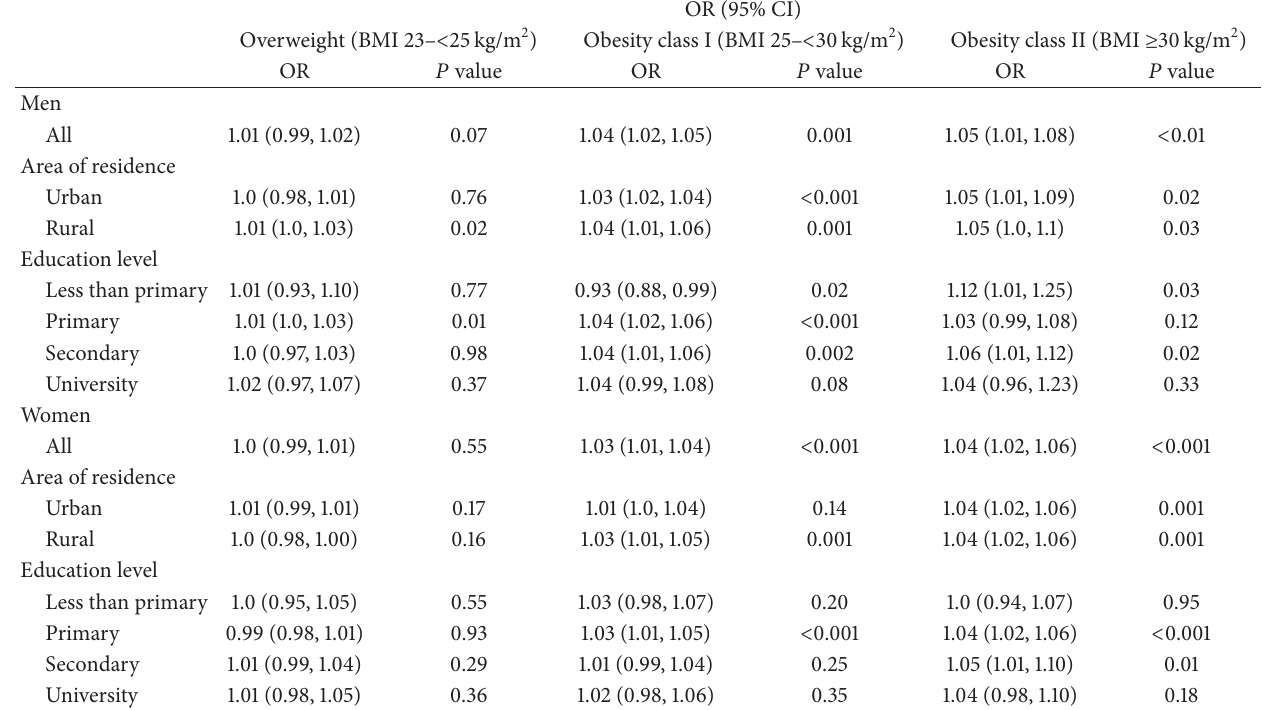
Table 3: Annual adjusted odds ratio (95% CI) for overweight, obesity class I and class II associated with educational levels in Thai adults